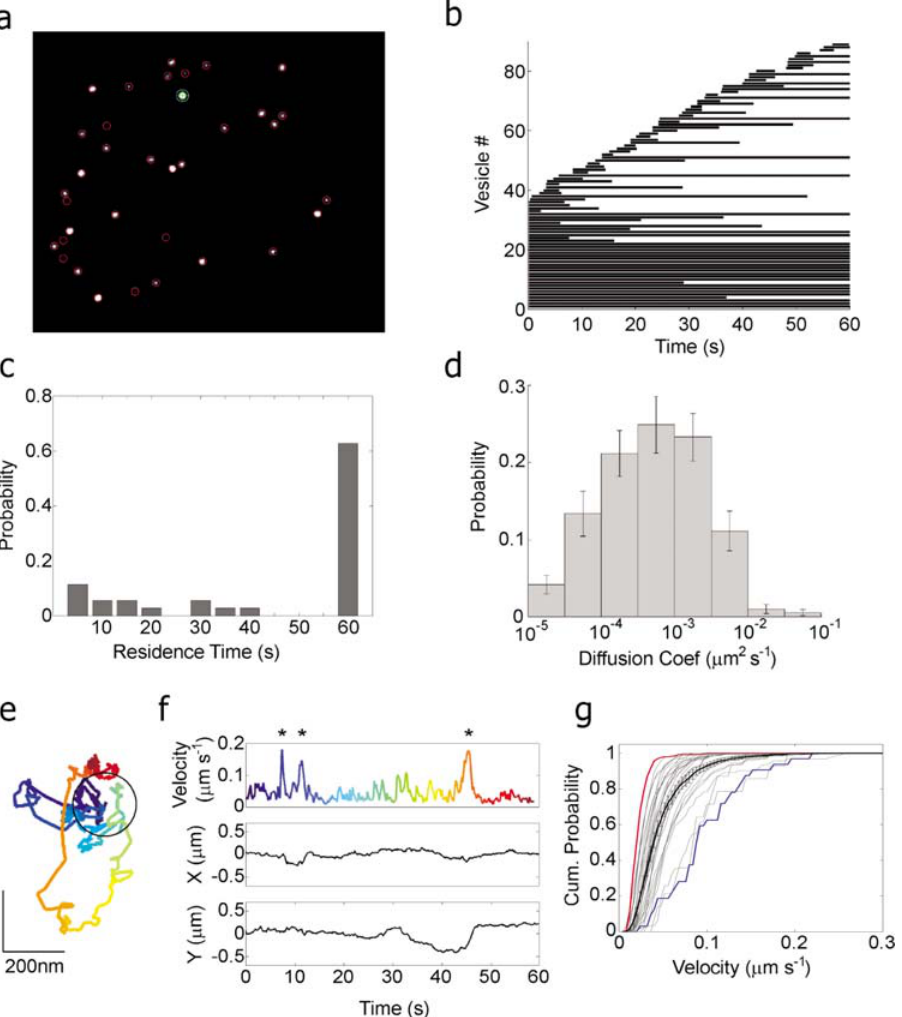
Figure 1. Tracking and mobility analysis of vesicles in a representative cell. (a) . First image in a time-lapse image sequence of a representative control cell expressing NPY-Venus. Vesicles (circled) were identified by their fluorescence profile and tracked throughout the sequence. Vesicles that appeared later in the sequence were also identified and tracked. (b) . A kymograph representing the duration of vesicle residence near the membrane. Individual vesicles are represented as lines initiating at vesicle appearance and terminating at vesicle disappearance from the TIRF plane (vesicles 1–39 were present at the start of the time-lapse sequence). (c) . Histogram depicting the lifetime distribution of vesicles in the representative cell shown in a . (d) . Average logarithmically binned histogram showing the distribution of vesicle diffusion coefficients in control cells (n=18 cells). (e) . Time-coded trajectory for the vesicle marked with a green circle in a . The vesicle was tracked for 60 s (see f for color code). Black circle indicates the size of an average chromaffin vesicle. (f) . For the same vesicle shown in e , X and Y coordinates are shown separately (middle and bottom traces, respectively) with a windowed-velocity graph (top) that is color-coded as in e . Asterisks denote periods of high mobility. (g) . Normalized cumulative-velocity histograms of all single vesicles in one cell (gray curves) and the mean histogram for the same cell (black; error bars represent SEM). Blue and red histograms describe the mobility of two representative vesicles with high and low mobility, respectively.